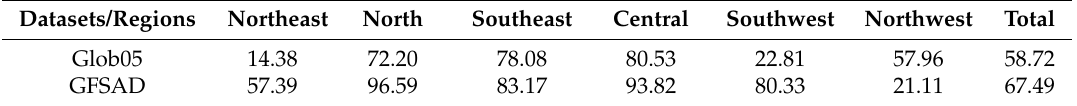
Table 3. Proportion of irrigated area accounted for by mosaic cropland pixels (MCPs) in Glob05 and GFSAD